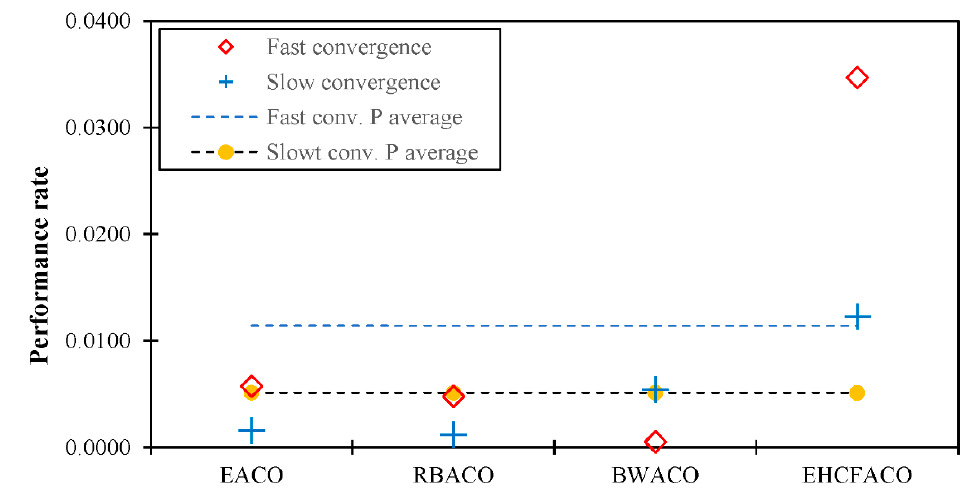
Figure 9. Performance rate of EACO, RBACO, BWACO, and EHCFACO algorithms.